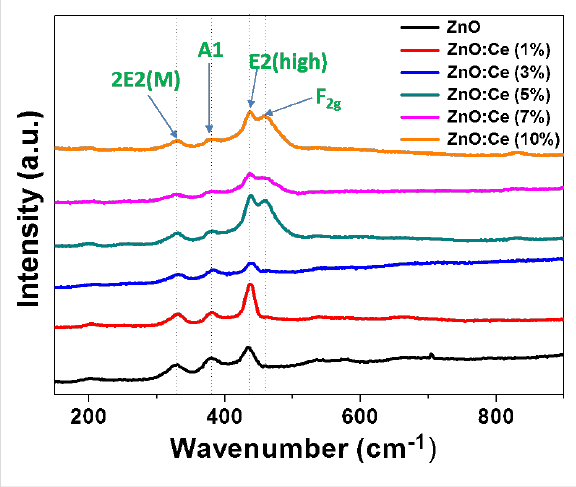
Figure 2: Raman spectra of ZnO and ZnO:Ce rods.